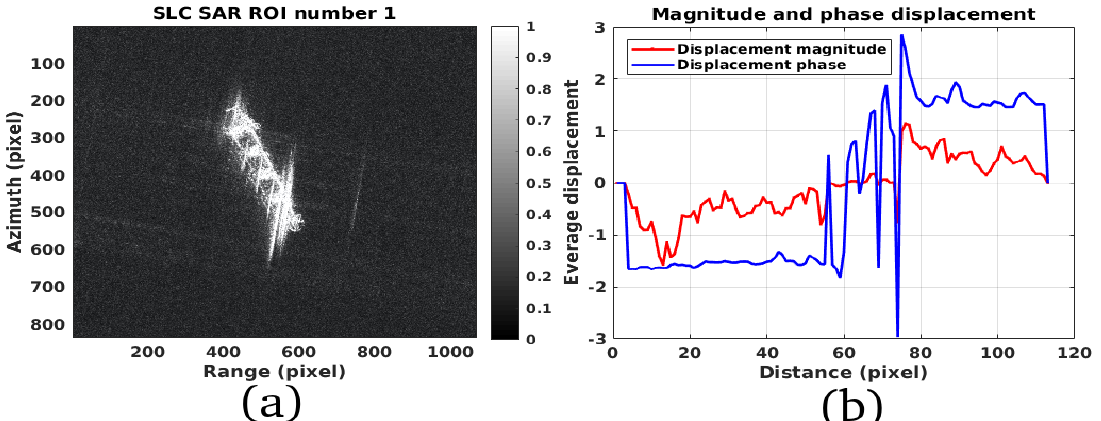
Figure 6. ( a ): SLC ROI. ( b ): Magnitude and phase displacement profile.